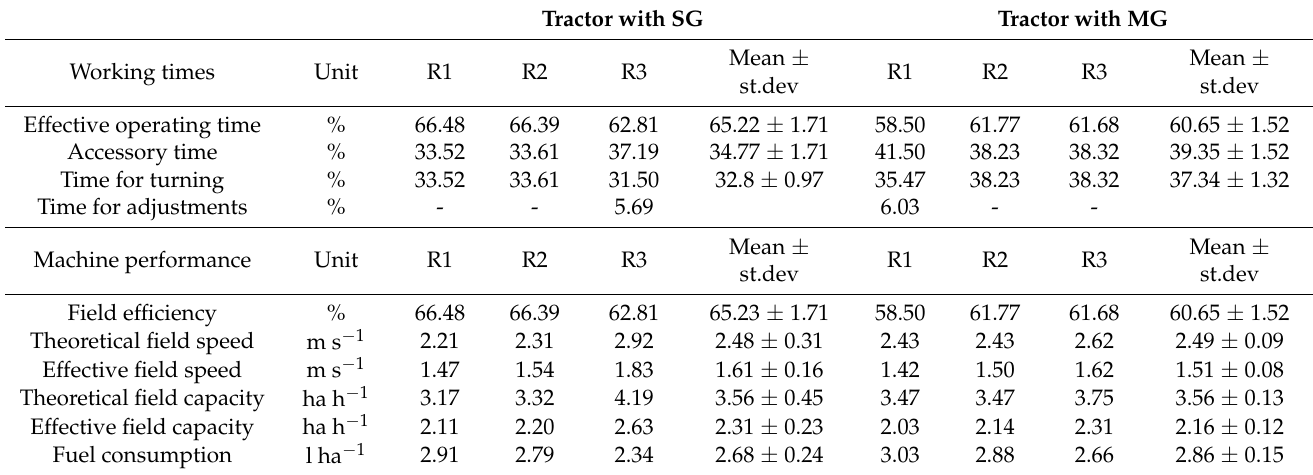
Table 3. Tractor performance semi-automatic guidance (SG). Tractor with SG Tractor with MG